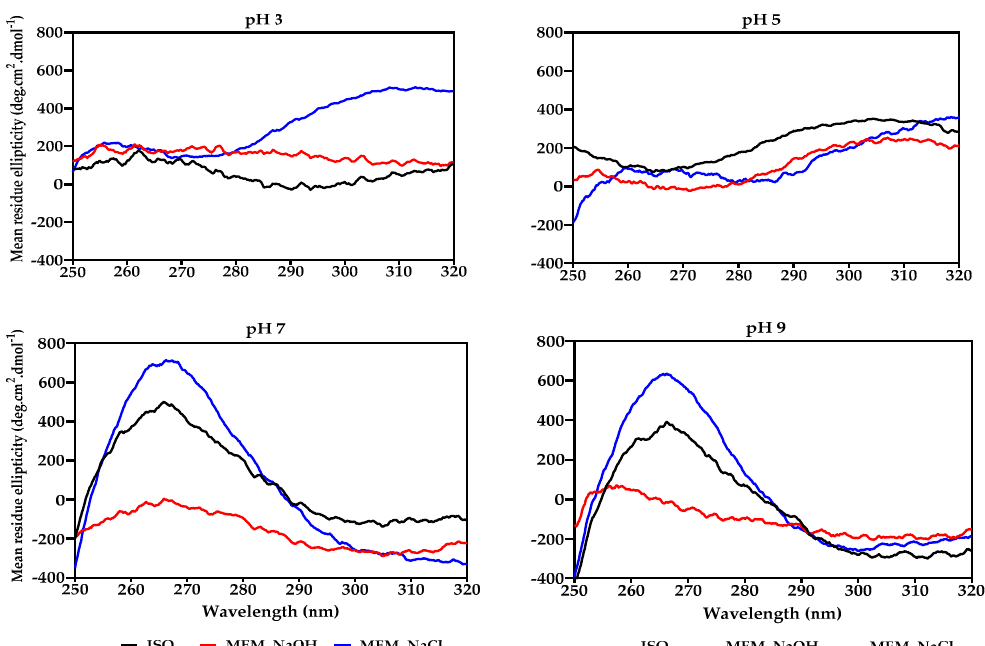
Membranes 2021 , 11 , x FOR PEER REVIEW Figure 3. Near_UV circular dichroism spectra at different pH values of isoelectric pH precipitated isolate (ISO), and membrane isolated proteins from alkaline (MEM_NaOH) and salt (MEM_NaCl) solution extracts.